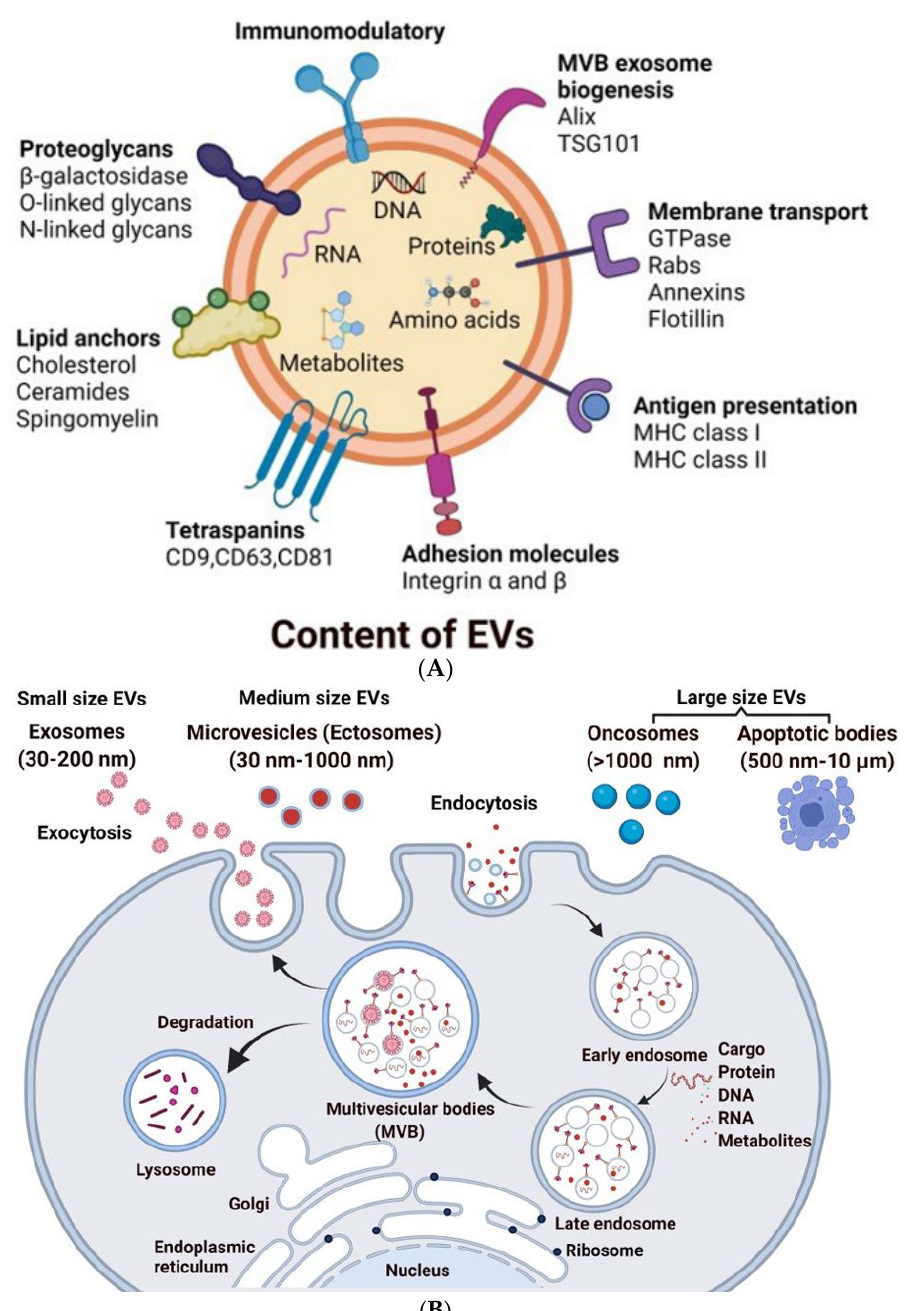
Figure 1. Schematic representation of the biogenesis of EVs: ( A ) Composition of EVs: EVs consist of cargo made up of bioactive molecules such as proteins, nucleotides, secondary metabolites, and lipids. Heat shock proteins (Hsp90 and Hsp70), Tetraspanins (CD63, CD9, and CD81), cytoskeletal proteins (Fibronectin and Actin), viral proteins (Tsg101), and enzymes are examples of proteins. EVs also contains DNA and RNA. ( B ) During endosomal maturation, multivesicular bodies (MVBs) develop, and exosomes are released when the MVBs fuse with the plasma membrane. Microvesicles, on the other hand, are derived directly via cell membrane budding and fission. Apoptotic bodies are formed by the death of apoptotic cells.